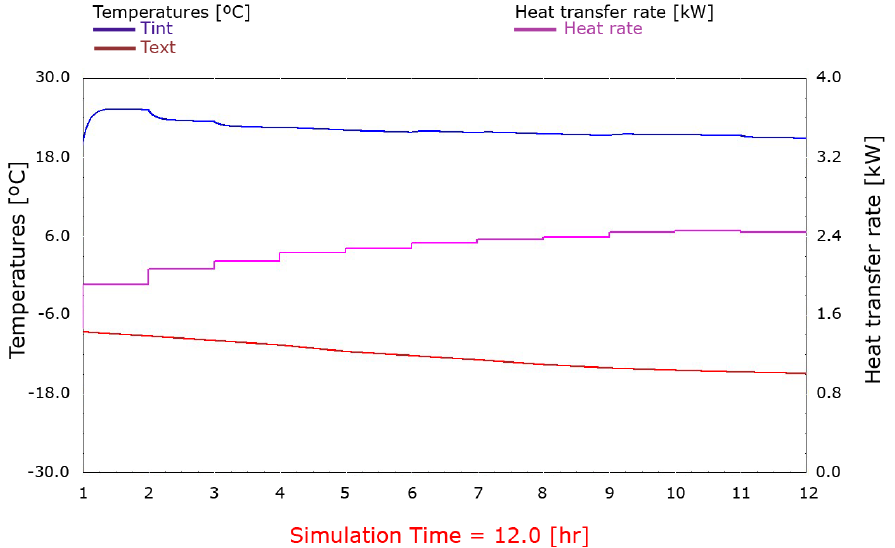
Figure 9. Simulation of the caravan in Berlin during the average night in January. The blue line represents the interior temperature in °C, and the red line represents the ambient temperature. The mean hourly heating rate of the SE is shown in the right axis in kW (pink